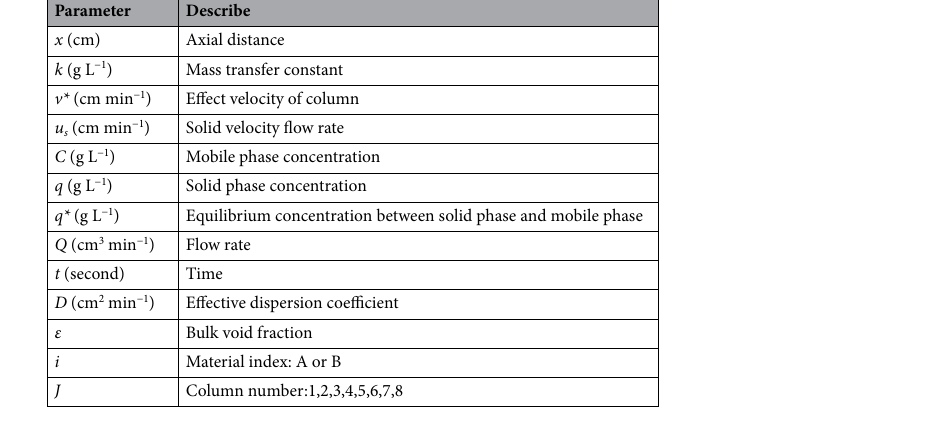
Table 1. Parameters of SMB